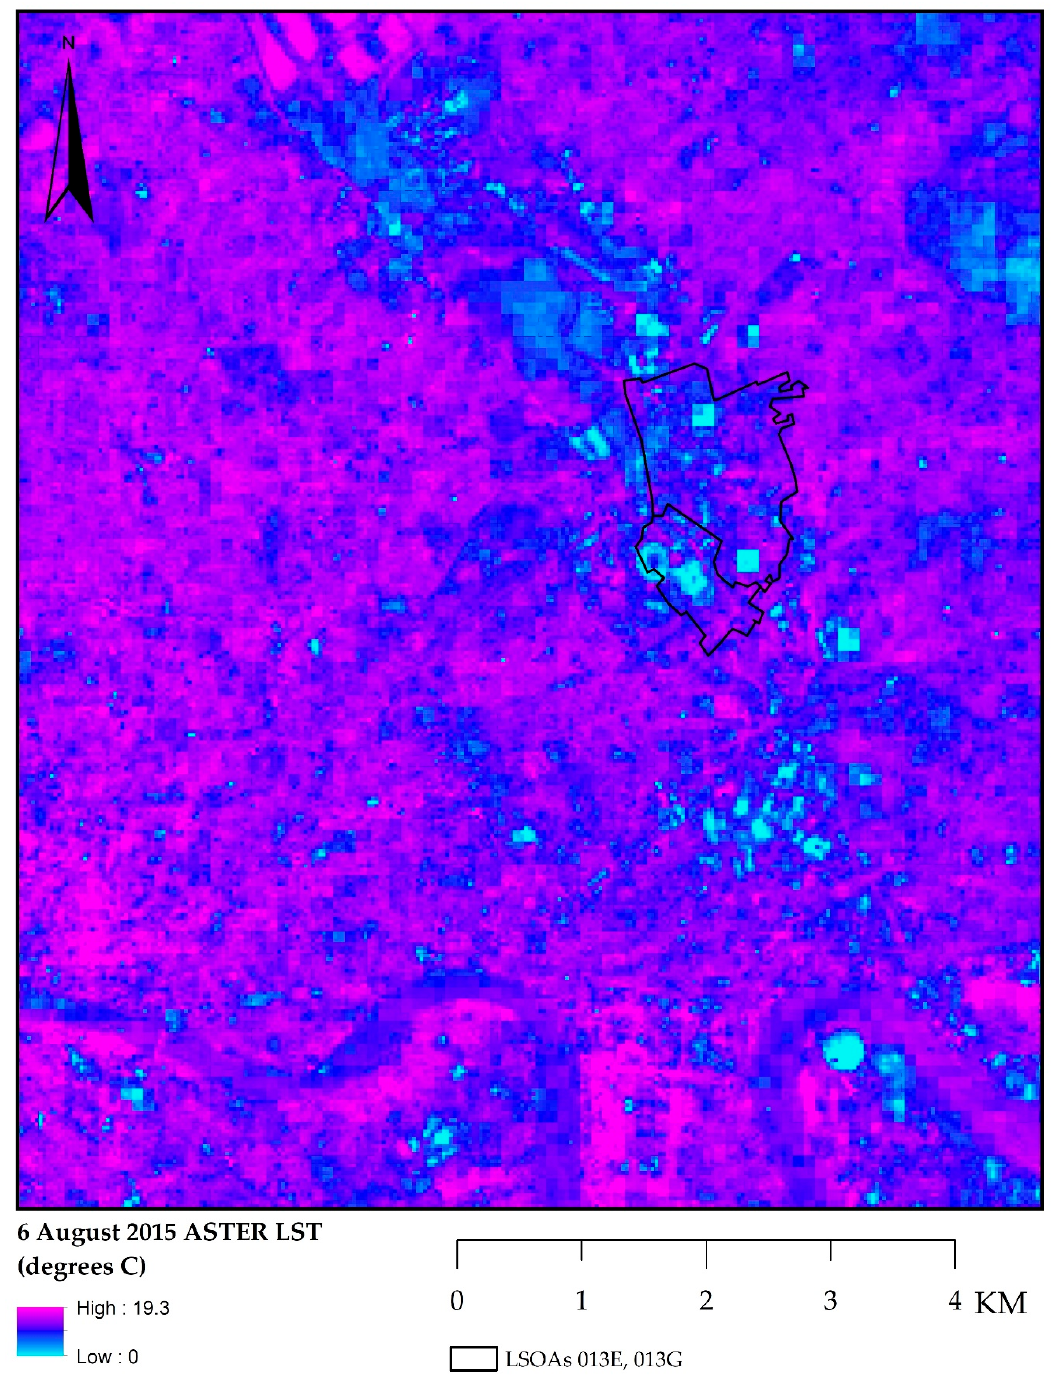
Figure 7. Map of land surface temperature development over London, derived from ASTER imagery acquired at 9:45 p.m. U.T. on 6 August 2015. acquired at 9:45 p.m. U.T. on 6 August